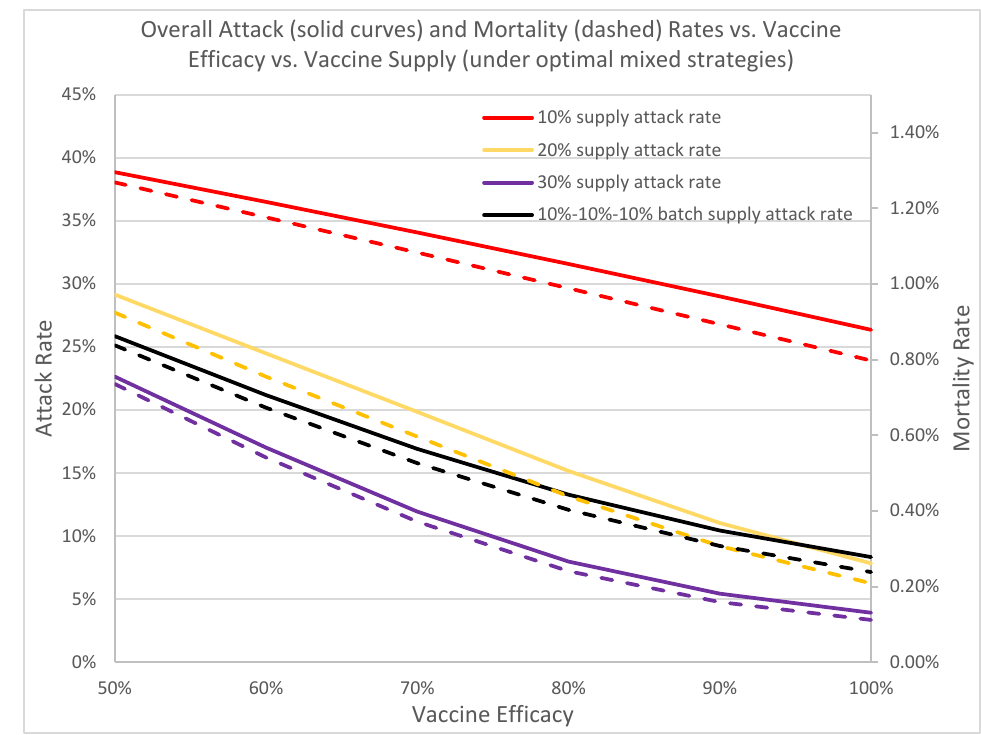
Figure 10. In this figure we depict the overall protection of the vaccine with respect to its efficacy across different levels of vaccine supply. The rapid decreases in attack and mortality rates across all vaccine supply levels as vaccine efficacy increases underscores the importance of rapid vaccination to contain the current outbreak and the development of booster shots to safeguard the public from new variants. Solid curves denote attack rates; dotted curves denote mortality rates.